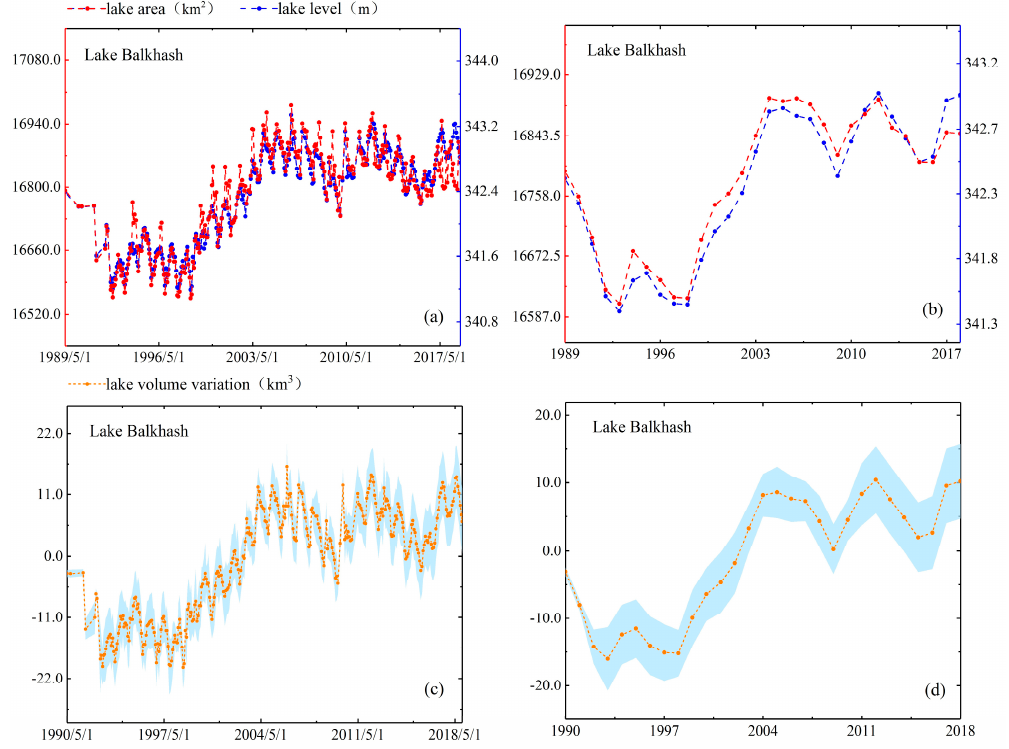
Figure 7. Lake area, level and volume variations in monthly ( a , c ) and annual ( b , d ) timescales for Lake Balkhash.